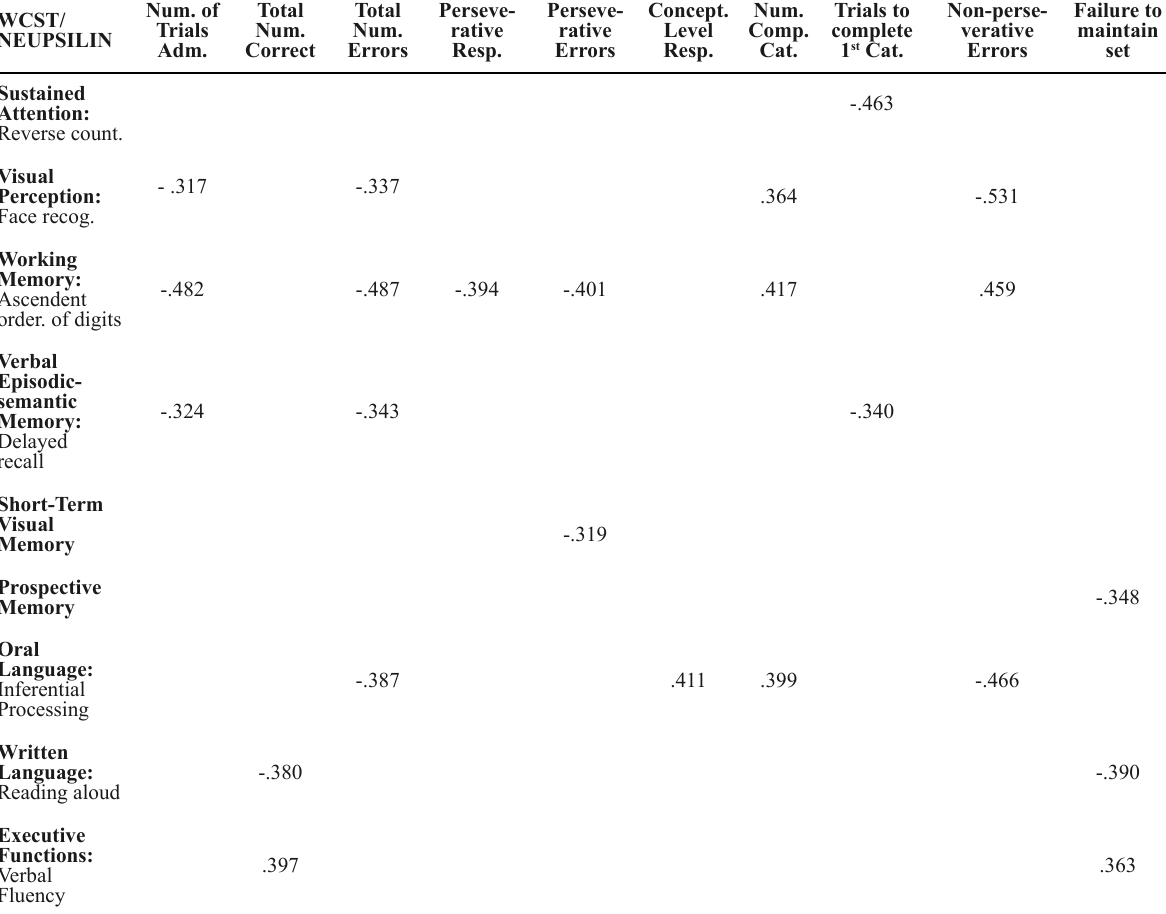
Table 2 Spearman Signi fi cative* Correlations between the WCST and NEUPSILIN scores. WCST/ NEUPSILIN